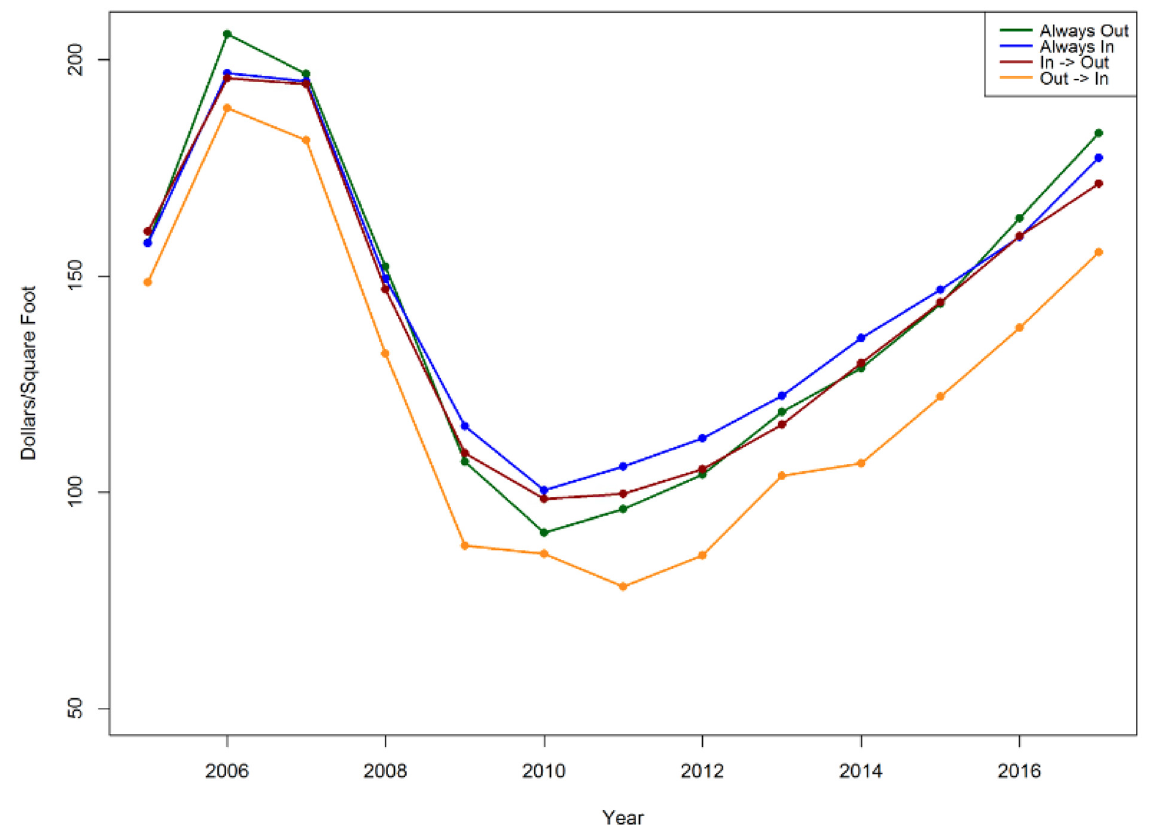
Figure 3. Temporal trend in sale price ($/per sqft), 2005–2011.